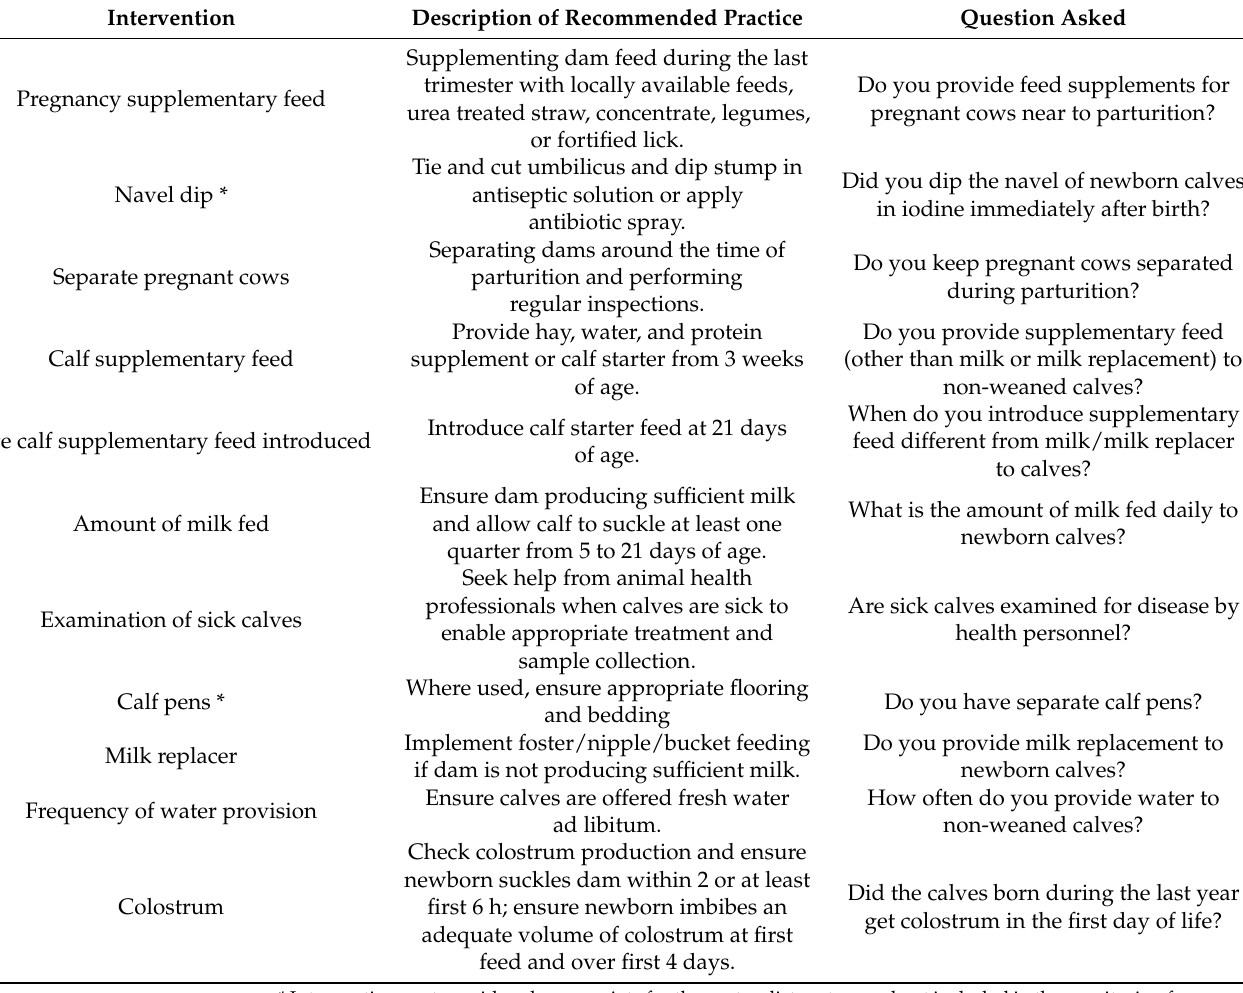
Table 2. Name and description of interventions for which household-level data were collected at baseline and final